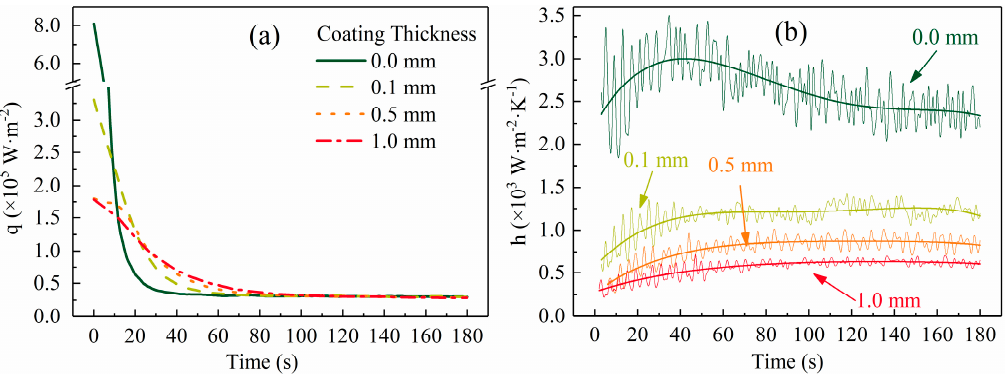
Figure 6. ( a ) Interfacial heat flux evolution for different coating thicknesses and ( b ) estimated interfacial heat transfer coefficient for different coating thicknesses. The high frequency waves of the curves resulted from the measurement error.